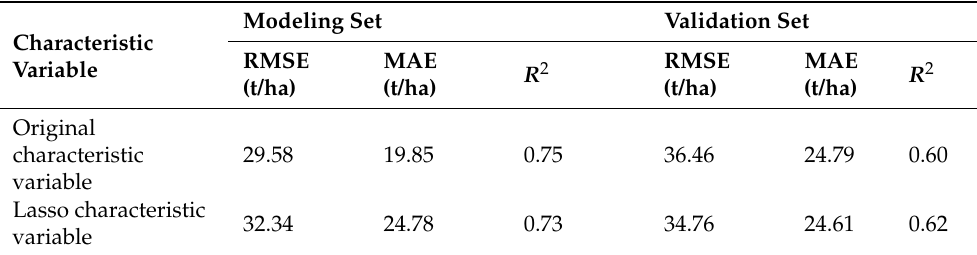
Table 4. Final verification results of feature variable screening.